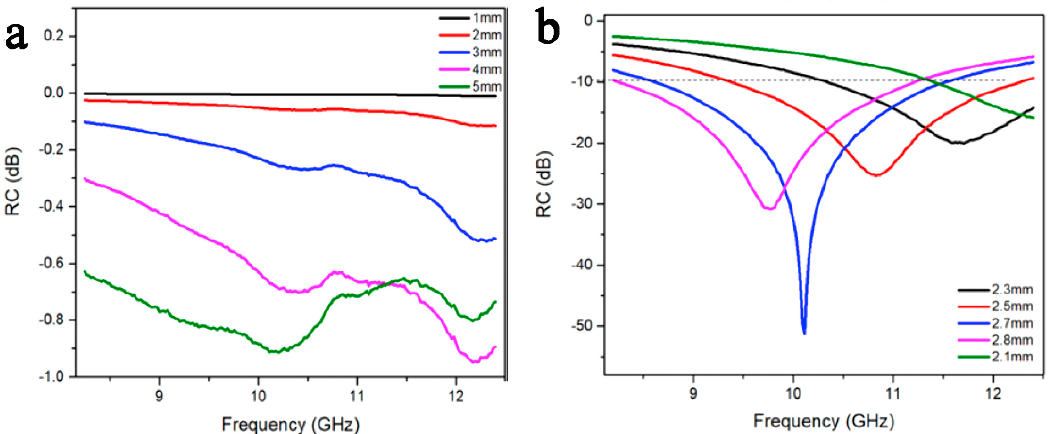
Figure 4. The influence of hierarchical carbon nanowire network on electromagnetic wave absorption properties of PDCs-SiCN. Without hierarchical carbon nanowire network ( a ); with 5.61 wt% hierarchical carbon nanowire network in PDCs-SiCN ( b ). The smaller the minimum reflection coe ffi cient, the better the electromagnetic wave absorption properties of the PDCs-SiCN [30]. Reproduced with permission from Ren F., Ceram. Int.; published by Elsevier,